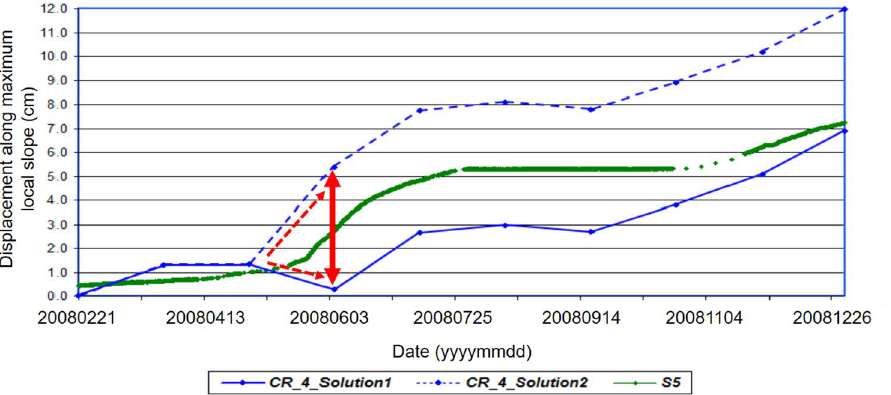
Figure 24. Displacement time series estimated with DInSAR over the CR_4 Corner Reflector, and measured by the wire-extensometer S5, located at a distance of 84 m. A DInSAR ambiguity is shown in red.